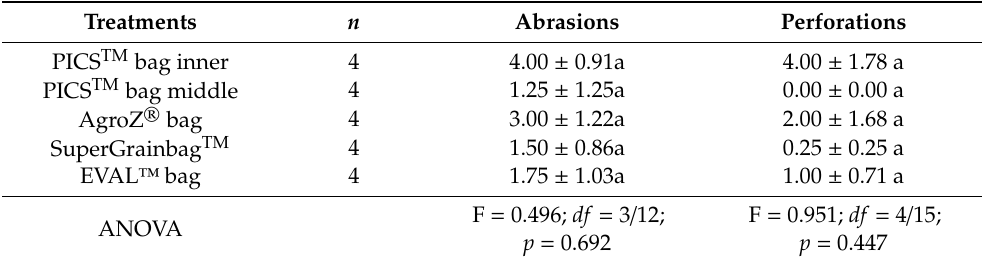
for 8 months in Maradi,